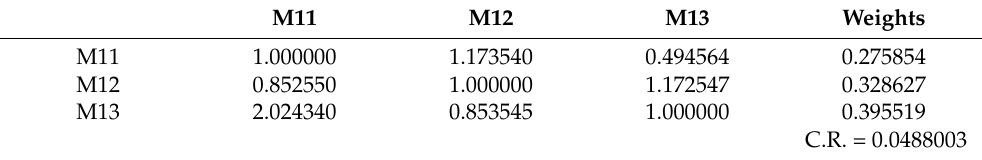
Table 10. Defuzzified pair-wise comparative matrix with parameter local weight for